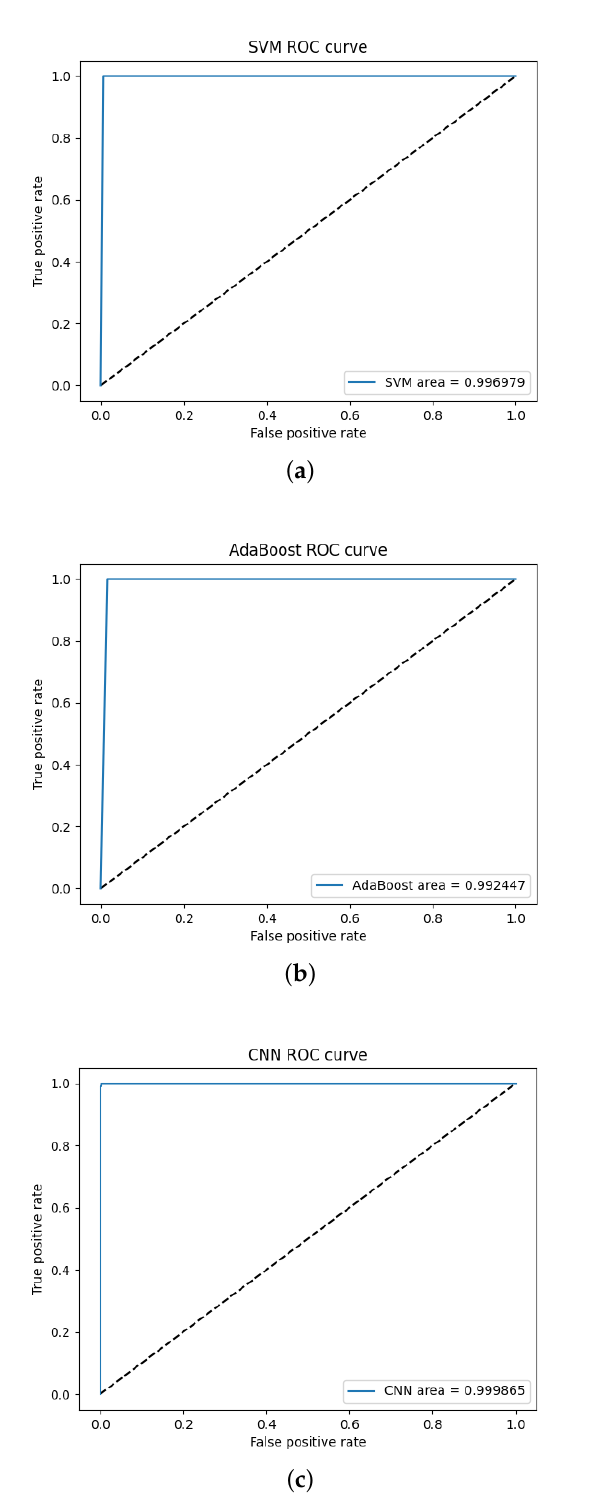
Figure 8. ( a ) ROC Curve of SVM with AUC = 0.996979, ( b ) ROC Curve of Adaboost with AUC = 0.992447, and ( c ) ROC Curve of CNN with AUC =